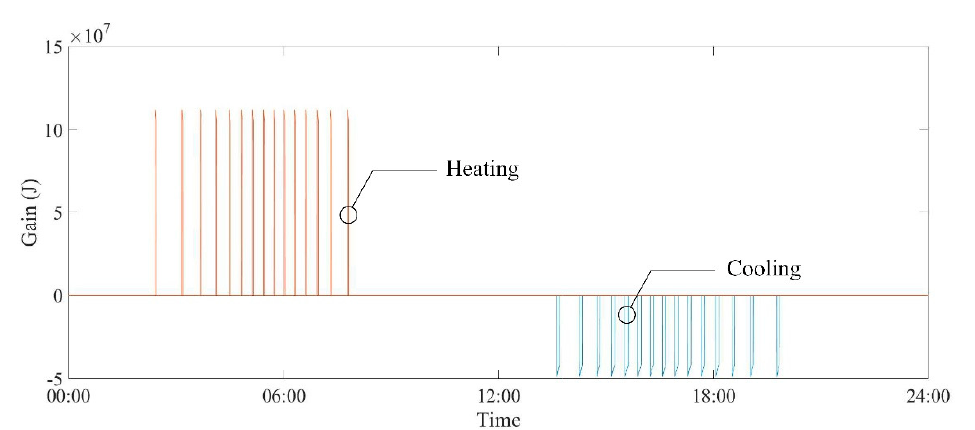
Figure 9. Energy use by On/Off at an abnormal condition.